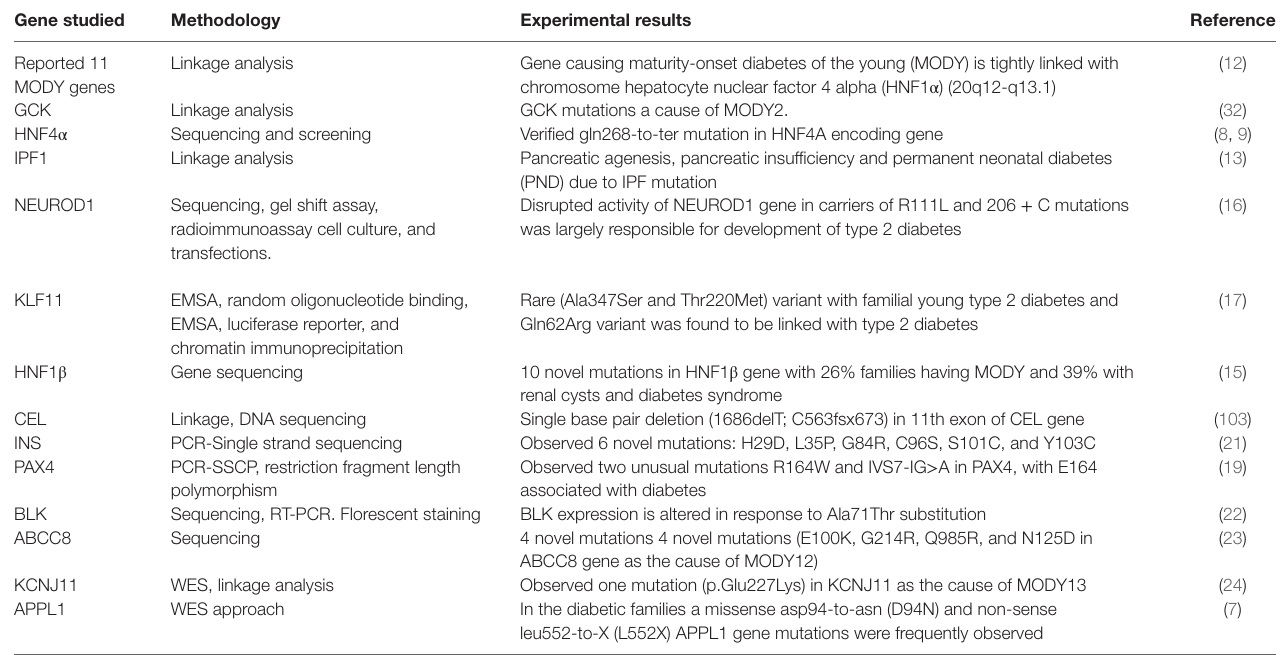
TAbLe 4 | Genetic testing methodologies (genetic screening and linkage